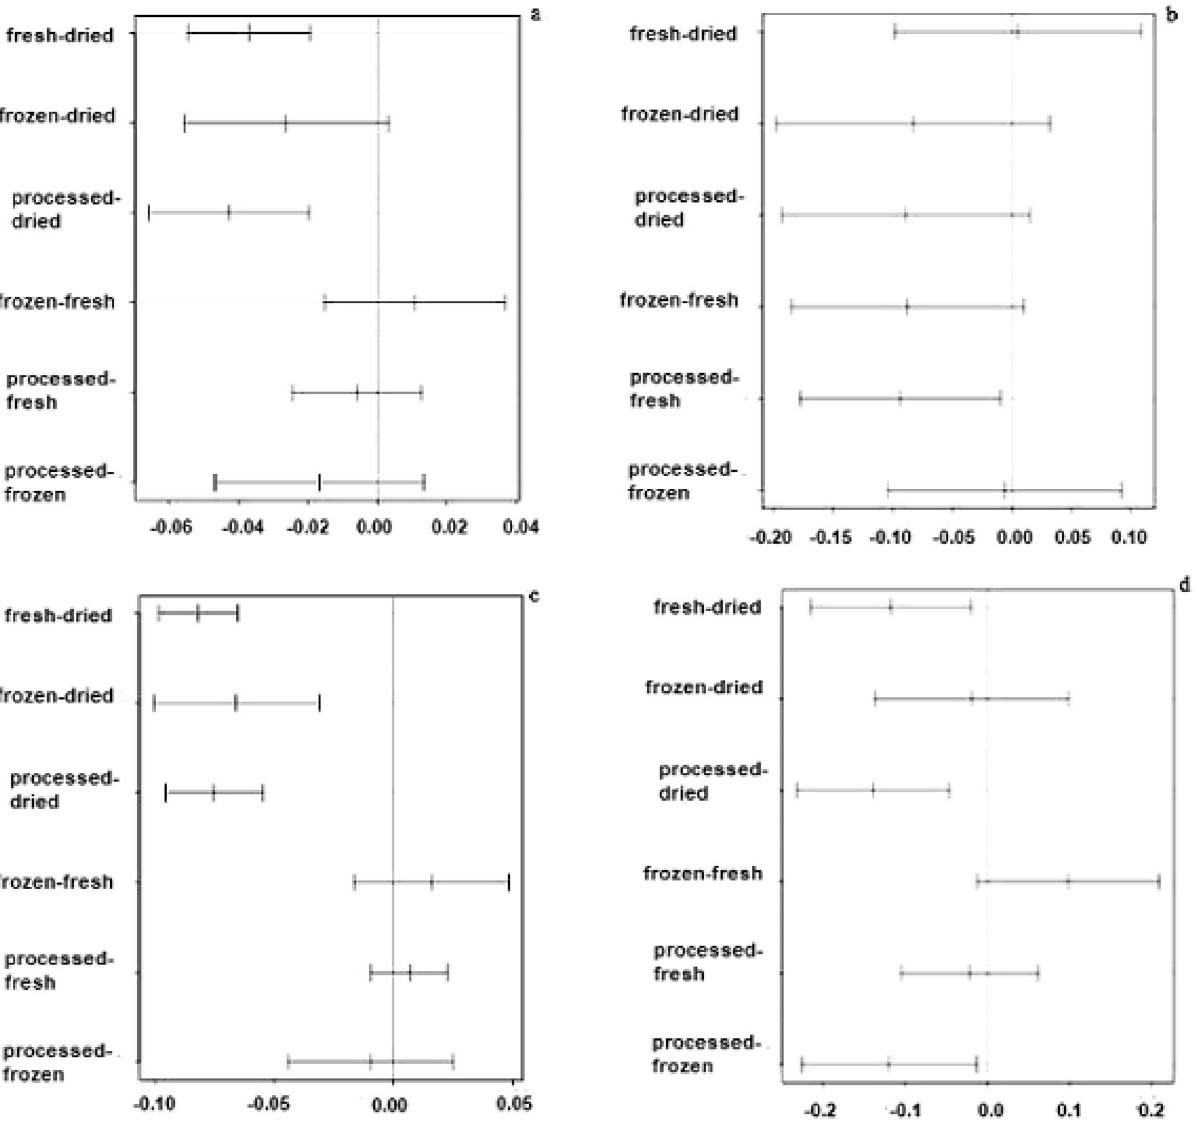
Figure 2. Post-hoc Multiple Comparison Tukey-Test of Cd and Pb in all samples of fruits and vegetables; differences in Cd mean concentration of: ( a ) fruits, ( b ) vegetables; differences in Pb mean concentration of: ( c ) fruits, ( d )